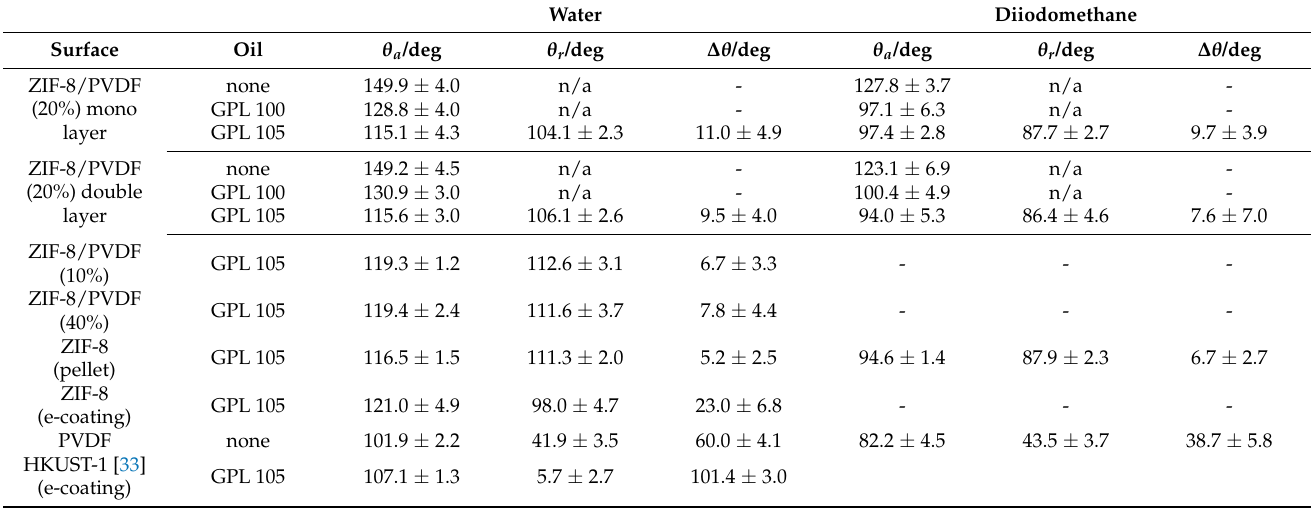
Table 2. Advancing contact angle θ a , receding contact angle θ r and contact angle hysteresis ∆ θ of water and diiodomethane measured on ZIF-8 and PVDF layers. For receding contact angles reported as n/a, droplet pinning occurred and the contact line showed no significant movement. Values for oil-infused HKUST-1 are taken from ref. [33] and included for comparison.